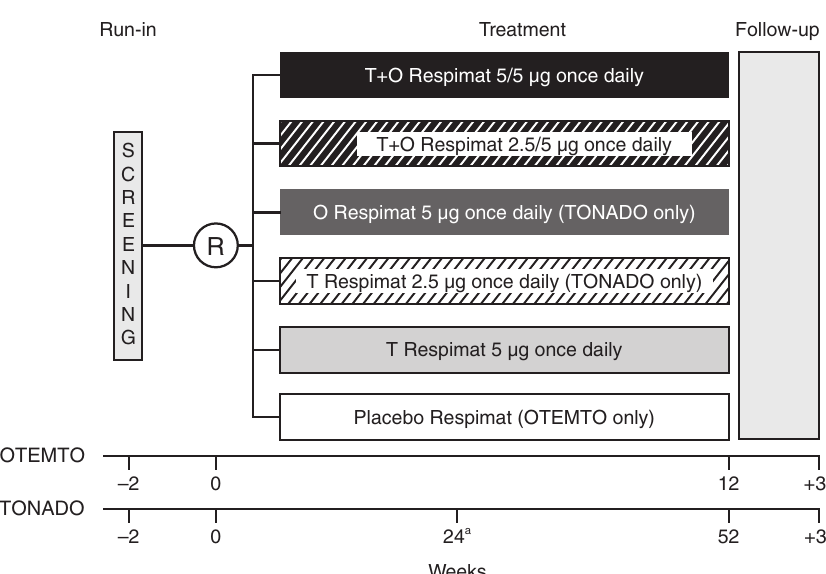
Fig. 6 OTEMTO and TONADO study designs. O, olodaterol; R, randomisation; T, tiotropium. a Primary end point